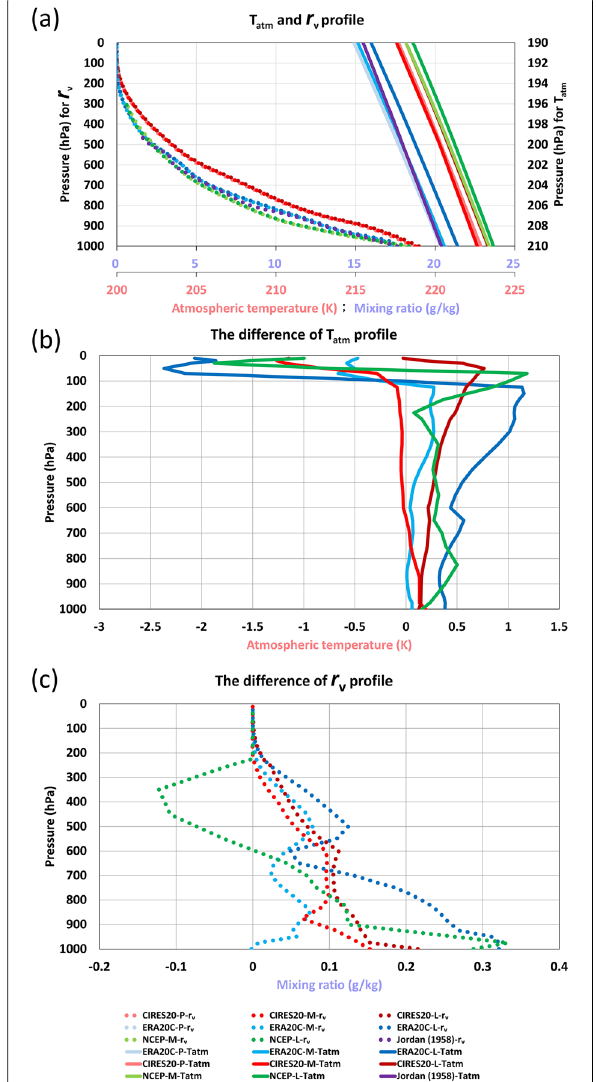
Fig. 2 a The spatially and temporally averaged vertical profiles of T atm (solid lines) in the upper troposphere and r v (dashed lines) for the following reanalysis data: NCEP/NCAR R‑1 (green), ERA20C (blue), and CIRES20 (red) and the vertical profile of Jordan (1958) sounding (purple). P is pre‑stage from 1921 to 1950, M is mid‑stage from 1951 to 1981, and L is later‑stage from 1981 to 2010. b The changes of T atm and c r v were calculated as differences between pre‑stage and other stages of reanalysis experiments, but differences between mid‑stage and later‑stage were calculated for NCEP/NCAR